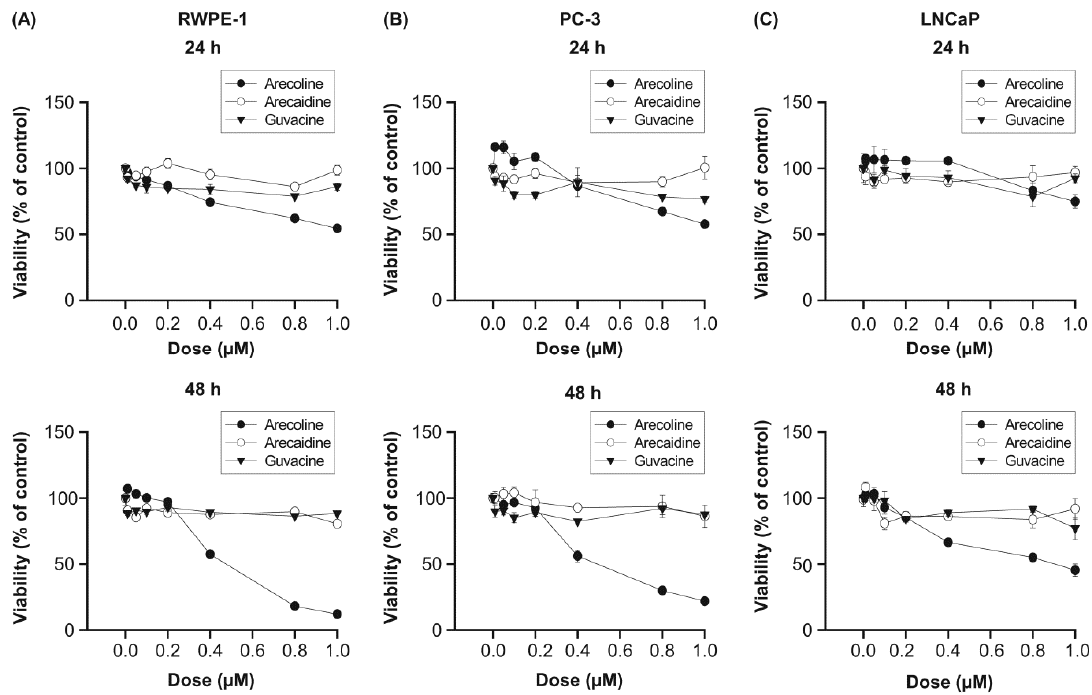
Figure 1. Reducing effect of betel nut alkaloids on the viability of normal RWPE-1 ( A ), cancerous PC-3 ( B ), and LNCaP ( C ) prostate cells with various concentrations (0–1 mM), duration (24–48 h) of treatment, and with different types of alkaloids. Data are expressed as the mean ± SEM from triplicate experiments. For clarity, statistical significance is not shown.